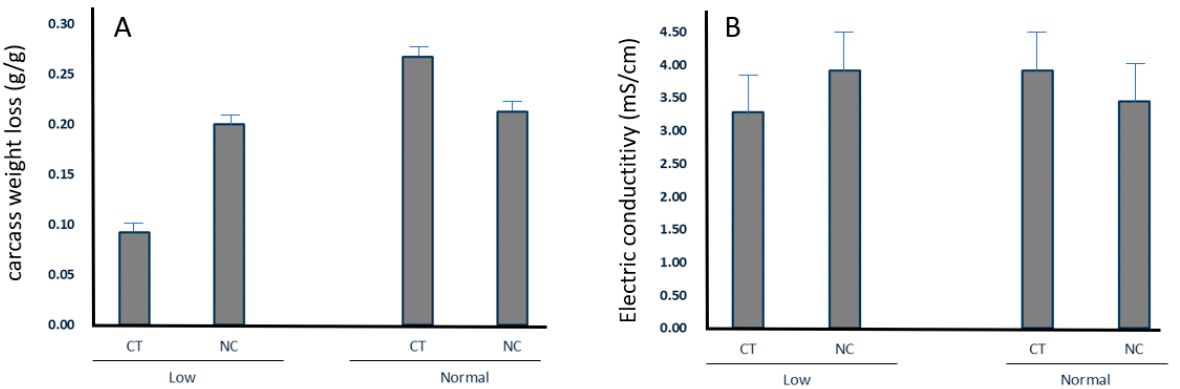
Figure 3. Interaction effect between neonatal care treatment and birth weight on carcass weight loss ( A ) and meat electric conductivity ( B ).